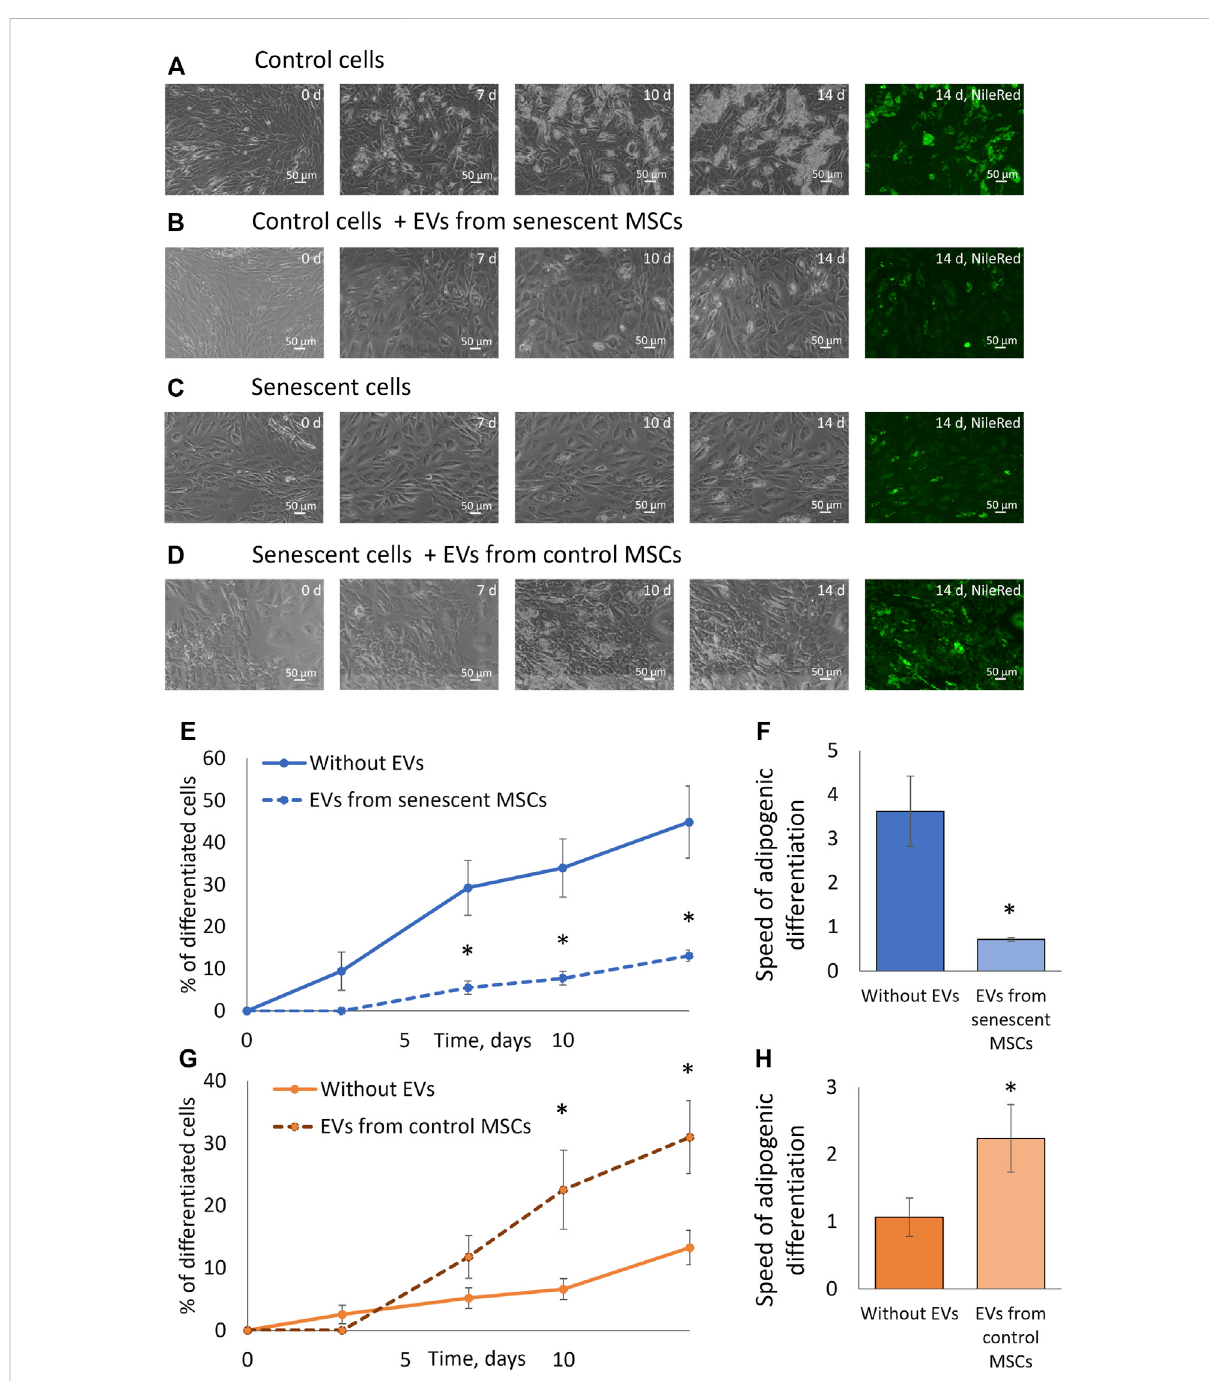
FIGURE 5 Extracellular vesicles affect the adipogenic potential of MSCs. (A) . Phase-contrast images of the dynamics of differentiation of control cells for 14 dayswithstainingwithneutrallipiddyeNileRedonthe14th day; (B) .Phase-contrastimagesofthedynamicsofdifferentiationofcontrolcellswith stimulation by EVs from senescent cells for 14 days with staining with neutral lipid dye NileRed on the 14th day; ( S ) . Phase-contrast images of the dynamics of differentiation of senescent cells for 14 days with staining with neutral lipid dye NileRed on the 14th day; (D) . Phase-contrast images of the dynamics of differentiation of senescent cells with stimulation by EVs from control cells for 14 days with staining with neutral lipid dye NileRedonthe14th day; (E) .DynamicsofincreaseinthenumberofcellsaccumulatingfatdropsduringadipogenicdifferentiationofcontrolMSCsin thepresenceofEVsfromsenescentcellsandwithout, n =7; (F) .Thetangentoftheslopeoftheincreaseinthenumberofdifferentiatingcontrolcells (differentiation rate) in the presence of EVs from senescent cells and without EVs, n = 7 – 11; (G) . Dynamics of increase in the number of cells accumulatingfatdropsduringadipogenicdifferentiationofsenescentMSCsinthepresenceofEVsfromcontrolcellsandwithoutEVs, n =6; (H) .The tangentoftheslopeoftheincreaseinthenumberofdifferentiatingsenescentcells(differentiationrate)inthepresenceofEVsfromcontrolcellsand without, n = 5 – 9. Mean ± SE, * p < 0.05, ** p < 0